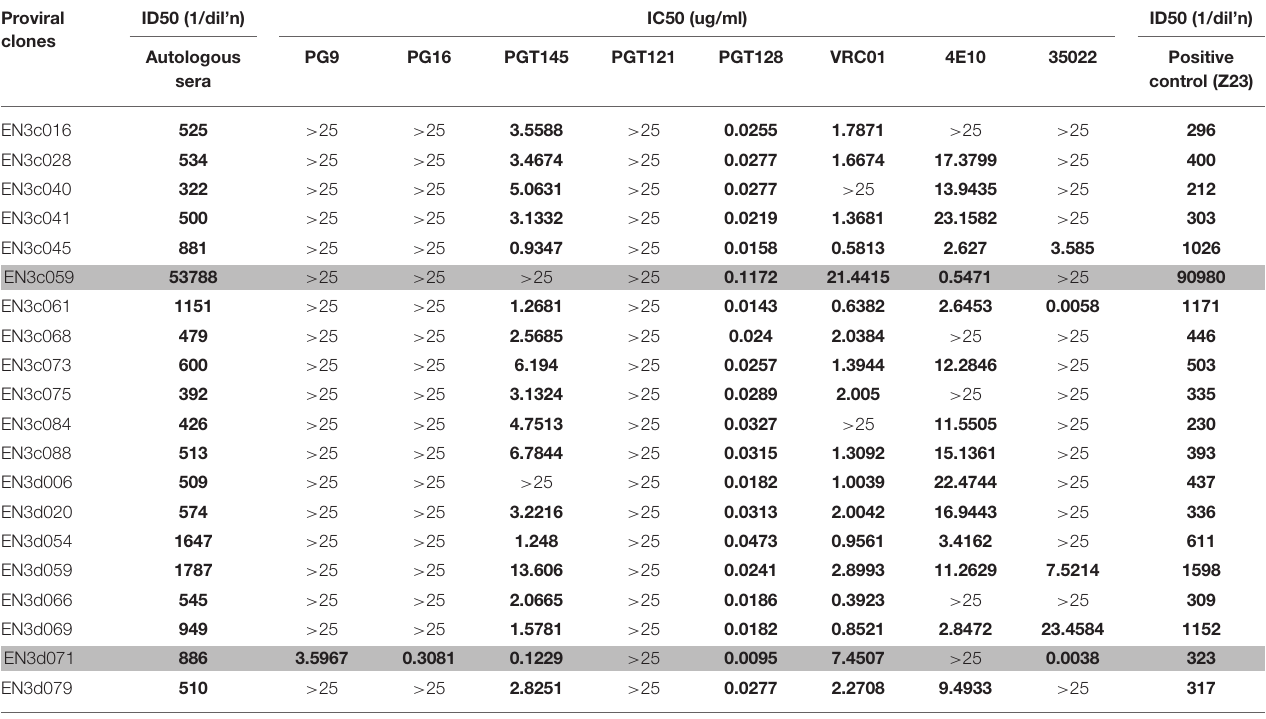
Pseudotype viruses for each EN3 sequence were tested against autologous sera and a panel of bn-mAbs with Monogram Biosciences’ PhenoSense ® assay. Each assay included acceptability criteria to ensure that interassay variation between ID50s, measured with reference standards, fell within 2.5-fold 95% of the time. The neutralizing antibody titer (ID50) for autologous sera and Z23 (a reference serum possessing broadly neutralizing antibodies) is defined as the reciprocal of the plasma dilution that produces a 50% inhibition in target cell infection. The neutralizing antibody titer (IC50) for monoclonal antibodies is defined as the concentration of purified mAb ( µ g/ml) that produces a 50% reduction in target cell infection.